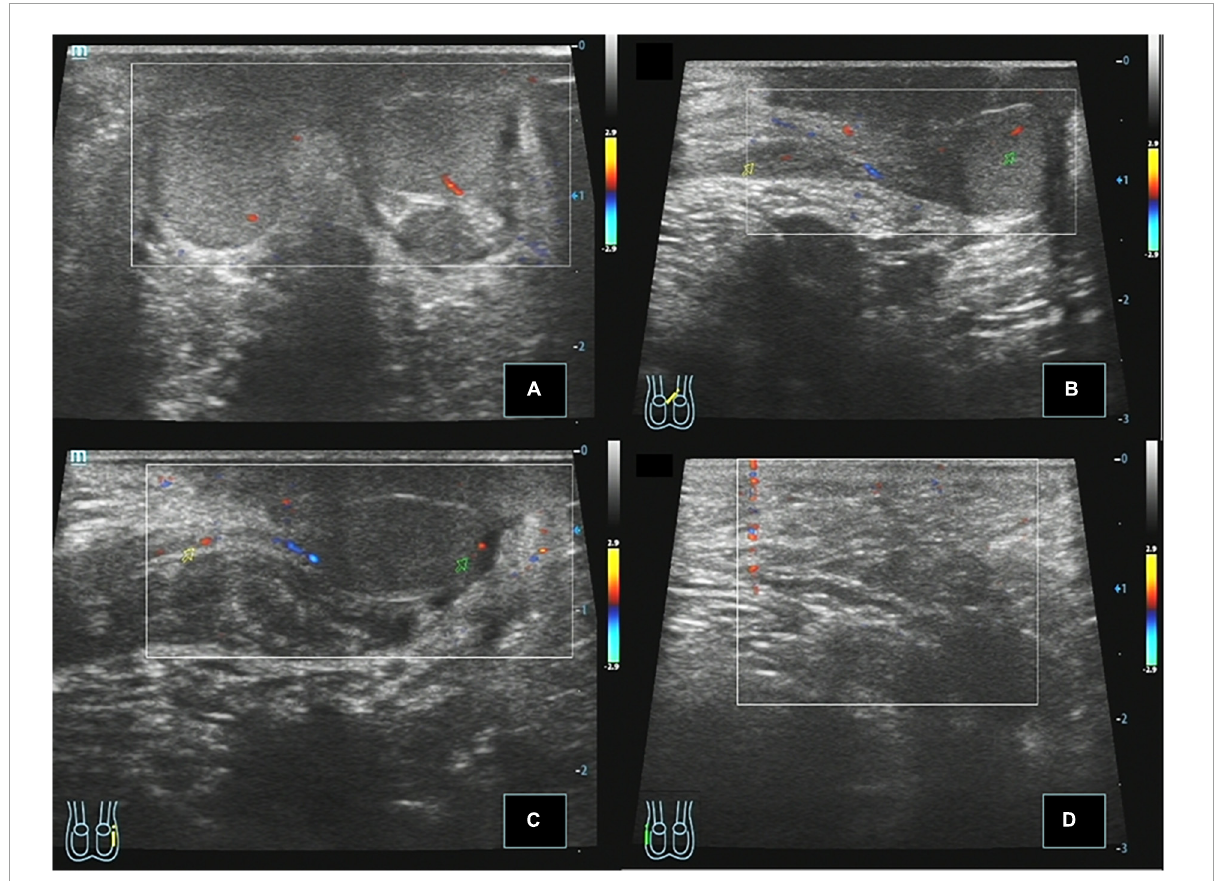
FIGURE3 Case 14, 0.8 years, 1 month after Ombredanne operation. Postoperative ultrasound: (A) Longitudinal section of the scrotum showing that both testes were located in the bilateral scrotum, respectively, and CDFI showed that the blood flow signal was normal in the parenchyma. (B) Longitudinal section of the left testis showing that the left spermatic cord continues to the left testis through the left inguinal region. (C) Longitudinal view of the left inguinal region showing that the right spermatic cord echoes across the perineum and continues with the testis in the right scrotum. (D) Longitudinal view of the right inguinal region showing no spermatic cord